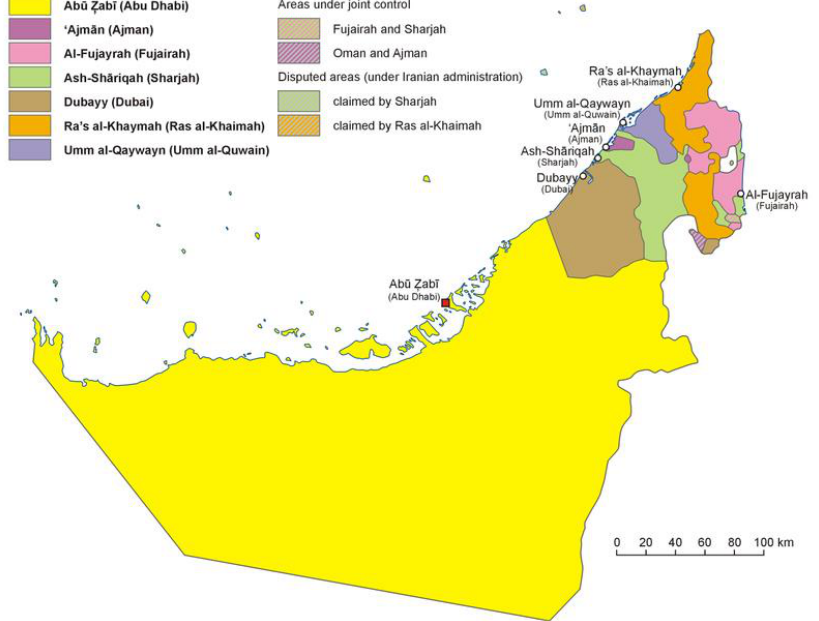
Figure 6. Administrative division map of the UAE. Reprinted from Ref. [18] with permission from Elsevier (Copyright 2018).